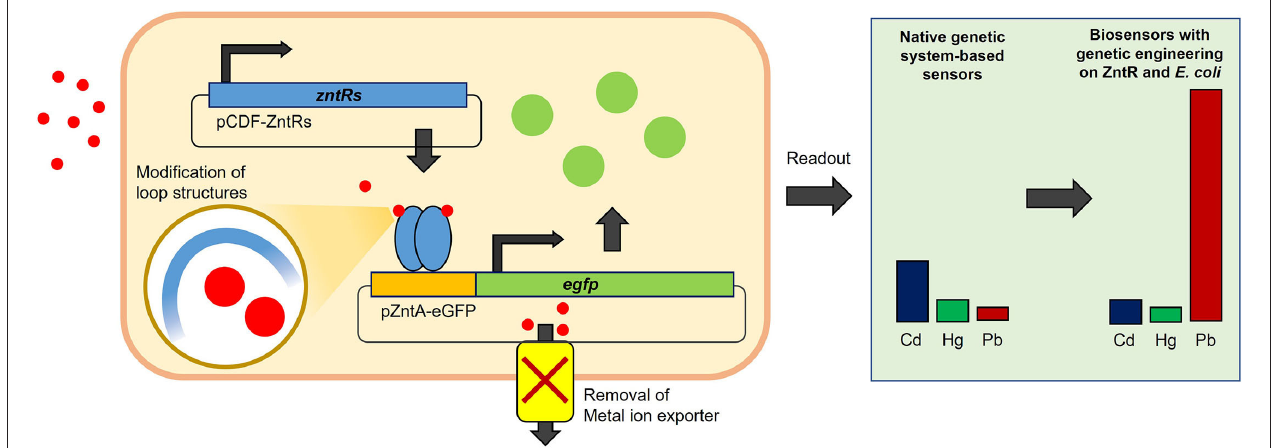
FIGURE 8 | A schematic figure for the working mechanism of biosensor system. The regulatory protein, ZntR, repressed the expression of eGFP by binding on zntA promoter region without metal ions, while ZntR induced the expression of eGFP upon conformational change by metal ion binding. The zntR deleted E. coli BL21 harboring pCDF-ZntR WT and pZntA-eGFP showed responses in the order of Cd, Hg, and Pb, while the responding order and strength were modulated with modification of ZntR loop structure and with deleting metal exporting channel in host